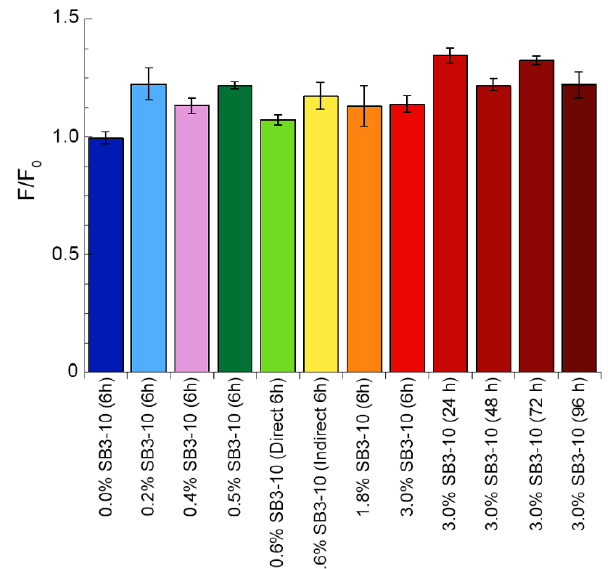
Figure 7. Thioflavin T (ThT) assay of TDP-43 NTD at different SB3-10 percent concentrations. TDP-43 NTD (0.5 mg/mL, 45 µM) in 5 mM sodium phosphate buffer, 50 mM NaCl, 1 mM DTT, pH 7.4, 25 °C, in the presence of the indicated SB3-10 percent concentrations ( w/v ) and time points. ThT assay was performed with excitation at 440 nm and fluorescence emission at 450–600 nm and reported as the ratio between ThT fluorescence at 485 nm in the presence ( F ) and absence ( F 0 ) of TDP-43 NTD (n = 3, mean ± SEM). Differences were in some cases statistically significant relative to the first sample in 0.0% SB3-10 at 6 h but considered to be non-relevant because an increase of the F/F 0 value is expected to be at least 5-fold for amyloid (see text for details).